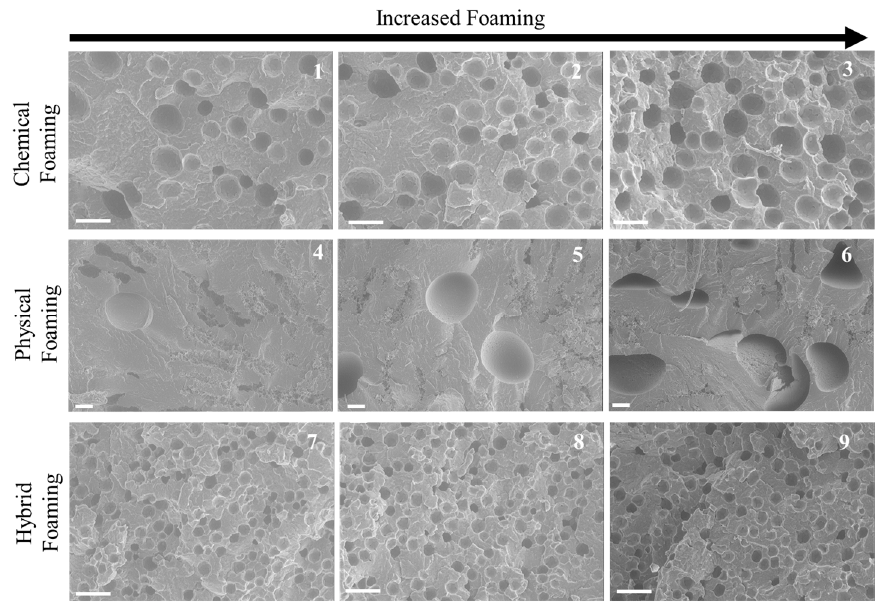
Figure 5. SEM images of unfilled PP cross-section (white bar indicates 100 µ m).